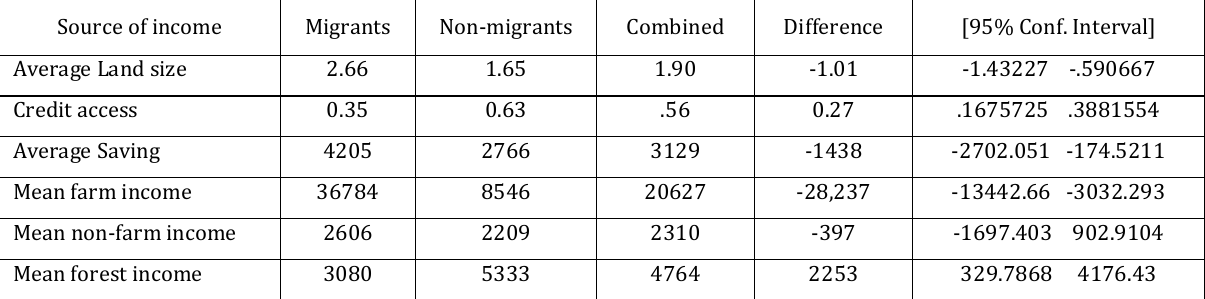
Table 4. Economic characteristics of sample households (Source: Own survey,